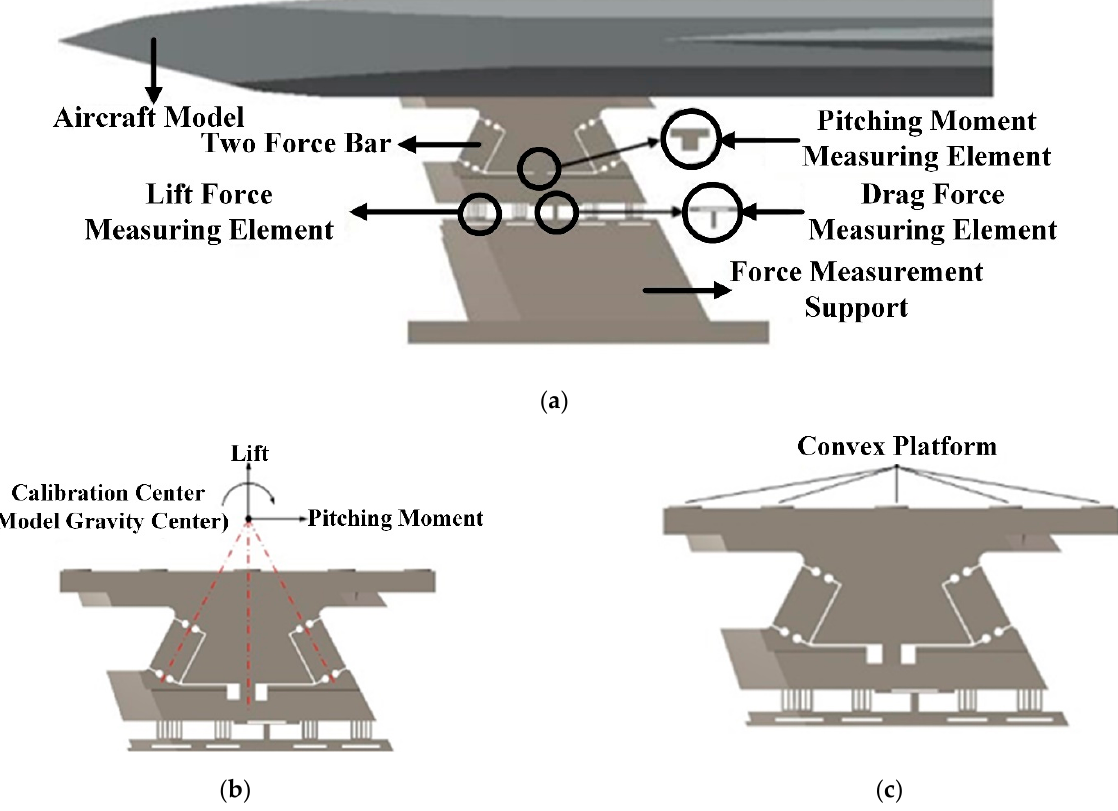
Figure 1. Three-dimensional model diagram of force measuring support. ( a ) The 3D model of AFMS. ( b ) The force measuring elements in AFMS. ( c ) The convex platforms in the joint of AFMS.